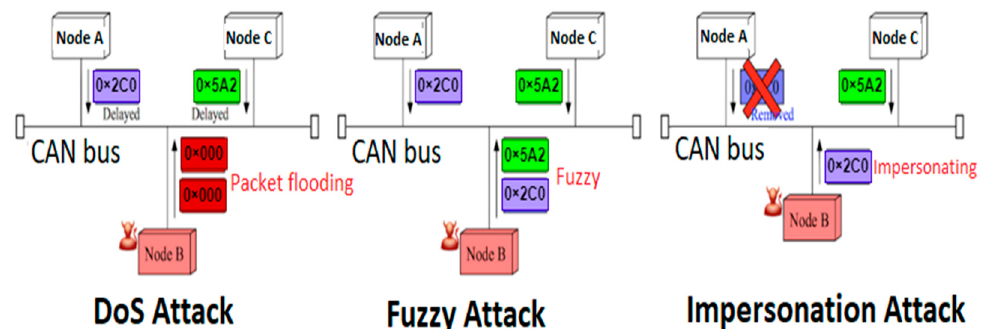
Figure 2. Three types of attack scenarios on a CAN bus.